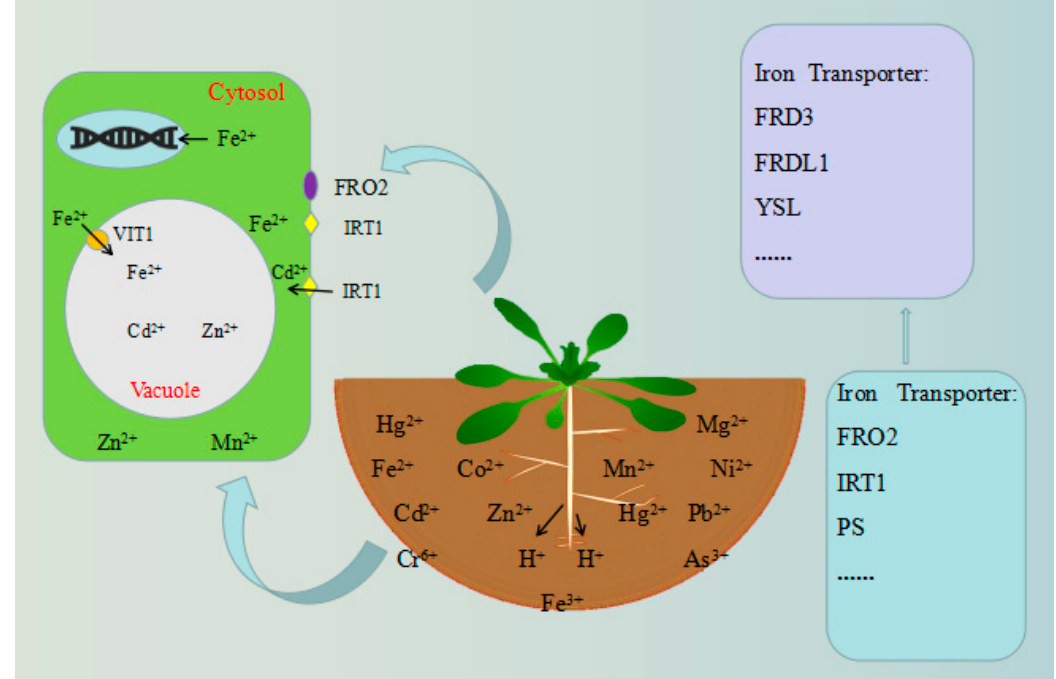
Figure 2. Tolerance mechanisms of model plants. Under the condition of iron deficiency, the four depicted mechanisms are upregulated in the root system. After that, iron is transported from the roots, through the xylem, to the shoots. Additionally, iron must also be transported to the cell compartments for utilization.